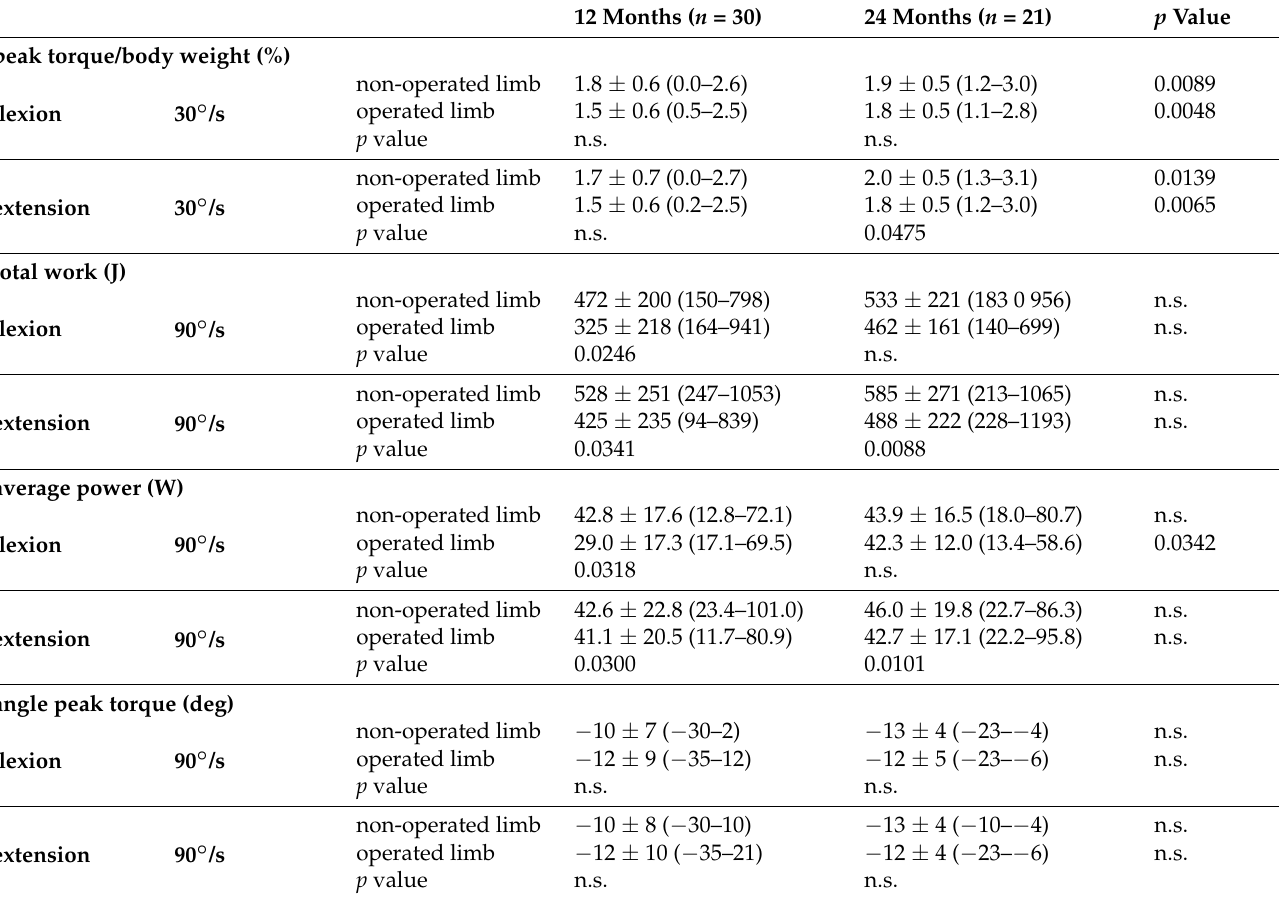
Table 6. The comparison of the isokinetic outcomes of the surgical procedure at two evaluation times. 12 Months ( n = 30) 24 Months ( n = 21) p